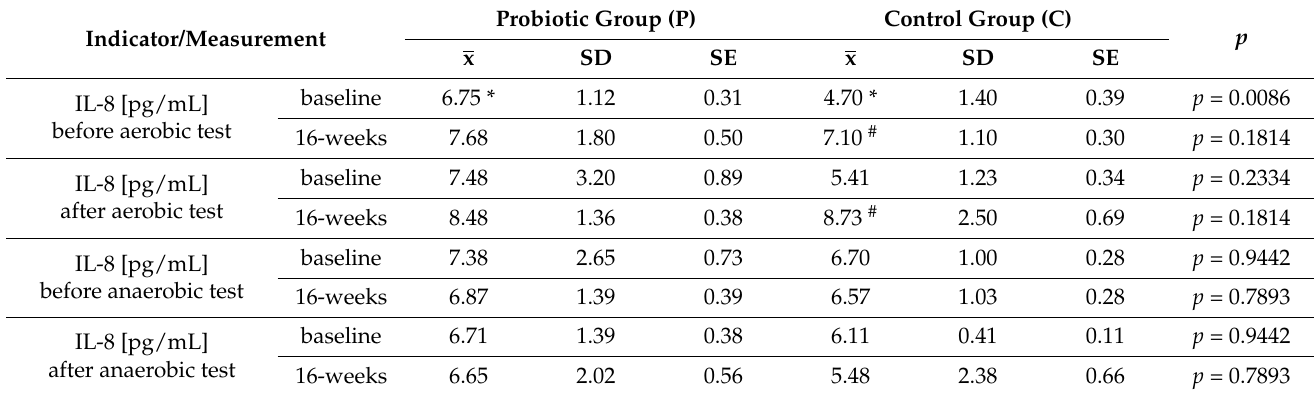
Table 11. The concentration of Interleukin 8 (IL-8) pre- and post-aerobic test and pre- and post- anaerobic test at follow-up measurements during supplementation